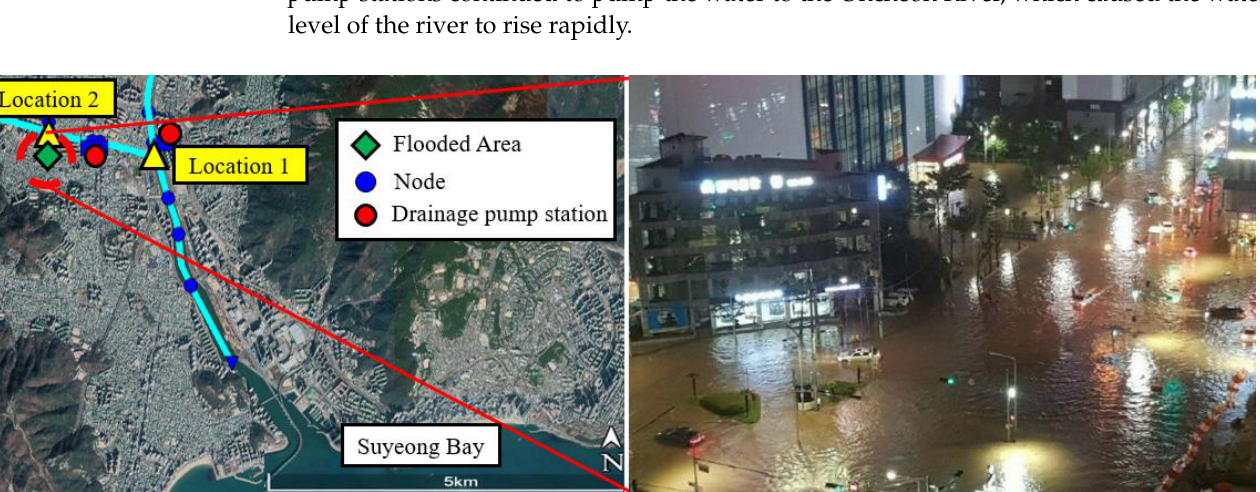
Figure 7. Flood Location in 23 July 2020 using SWMM (right photo: provided by Busan Police Agency).